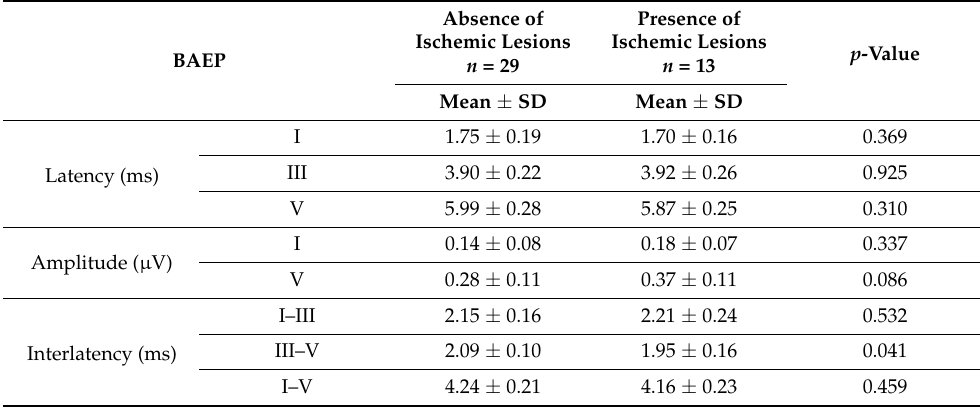
Table 5. SEP values in patients with and without vascular lesions on MR imaging. SEP